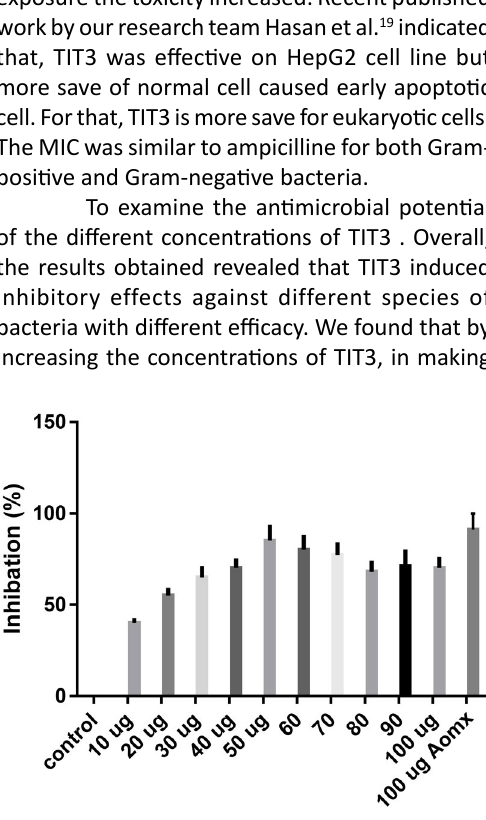
Fig. 2. Inhibation of S.aureus Conentrations of TIT3 (ug) Fig. 3. Inhibation of Salmonella typhimurium Concentrations of TIT3 (ug)